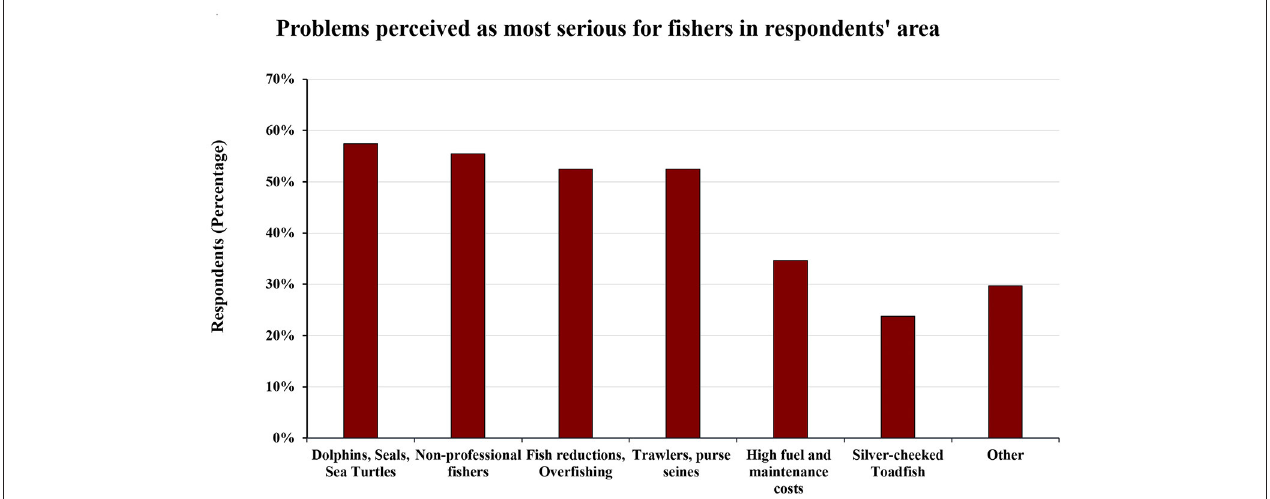
FIGURE 7 | Top problems for the local fishery on Crete as reported by the respondents. When asked to list the three most serious problems for small-scale fisheries in the area, interactions with sea turtles, dolphins and seals combined rated highest amongst fishermens’ problems. Problems can be separated into subsets: (a) those associated with environmental conditions like interactions with marine vertebrates and silver-cheeked toadfish and (b) those having to do with fishing activity in general (competitive fisheries, high operating